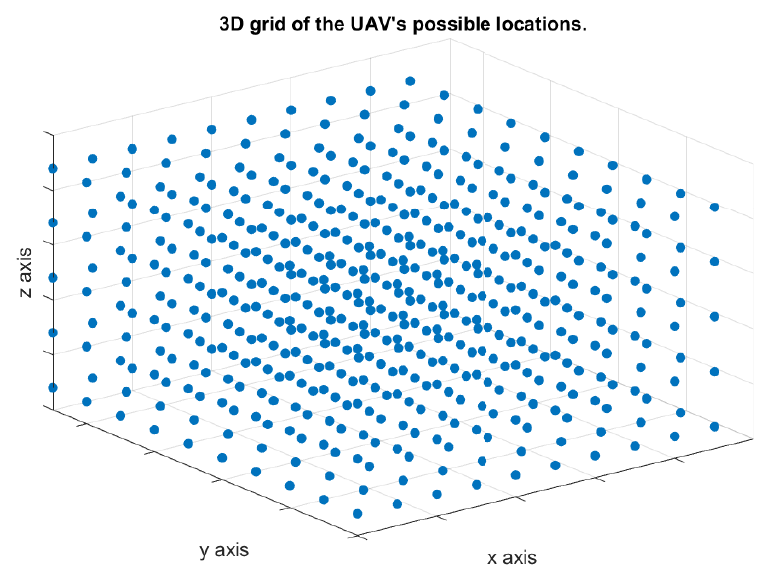
Figure 2. Three-dimensional path loss